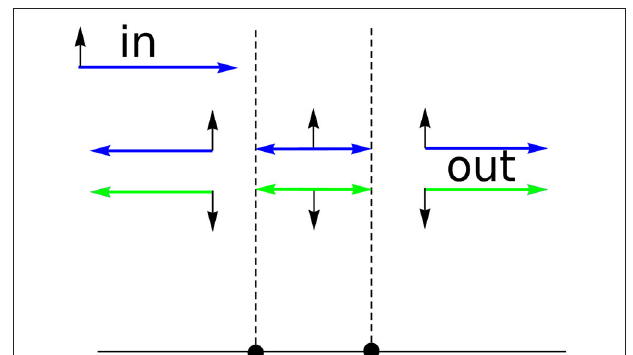
FIGURE 5 | Amplitude of the wave function resonant region.